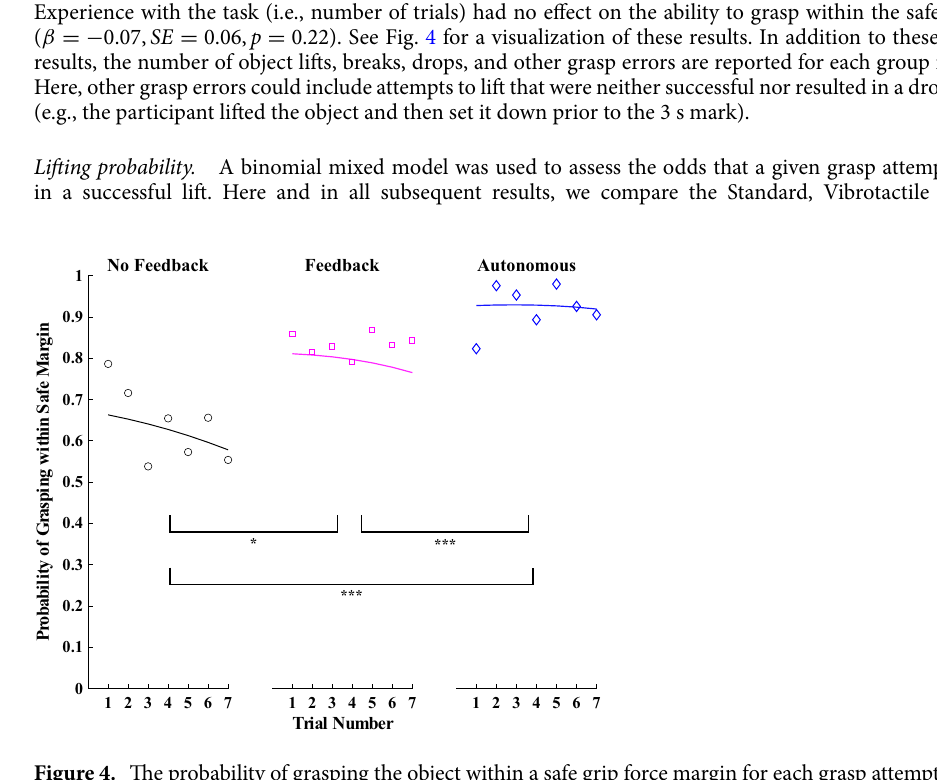
Figure 4. The probability of grasping the object within a safe grip force margin for each grasp attempt, where the individual data points represent the average for each trial (for all participants in each mode), and the solid lines indicate the model’s prediction. Note: the No Feedback mode refers to manual prosthesis operation, the Feedback mode refers to manual prosthesis operation with vibrotactile feedback, and the Autonomous mode refers to autonomous prosthesis operation. * indicates p < 0.05 , ** indicates p < 0.01 , and *** indicates p < 0.001